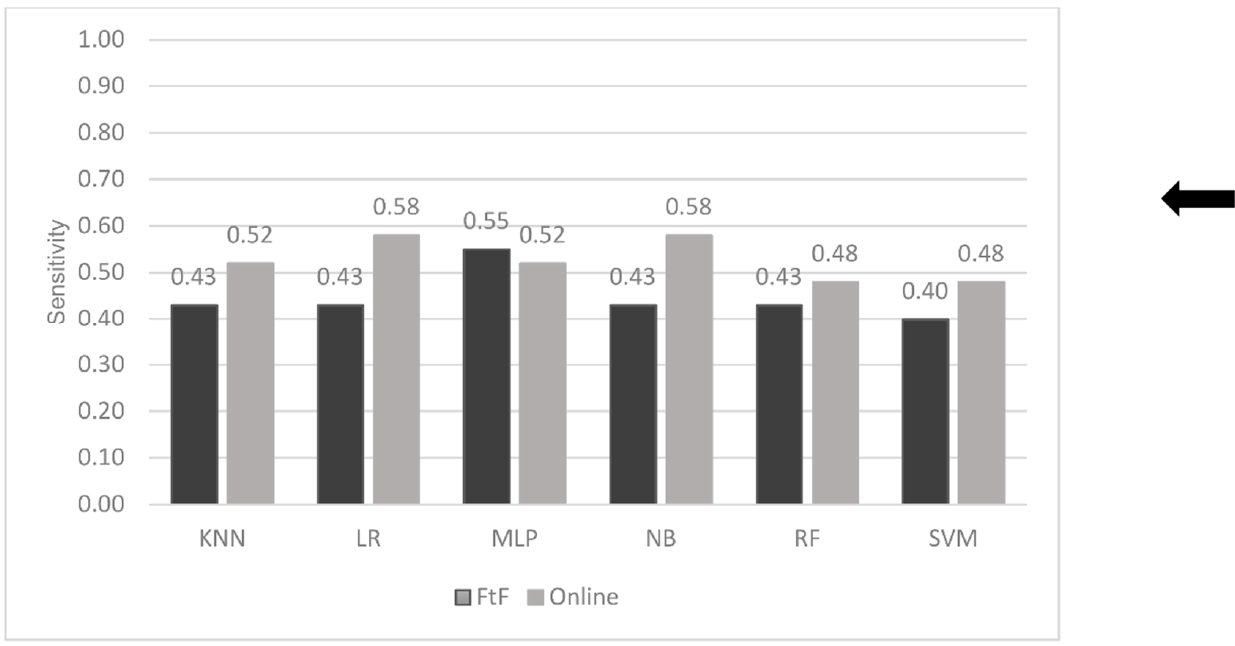
Figure 7. PSY course: prediction of at-risk students (sensitivity scores) by instructional mode .